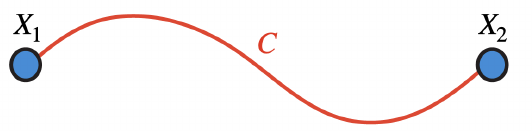
Figure 4 . Setup of a curve that defines a line